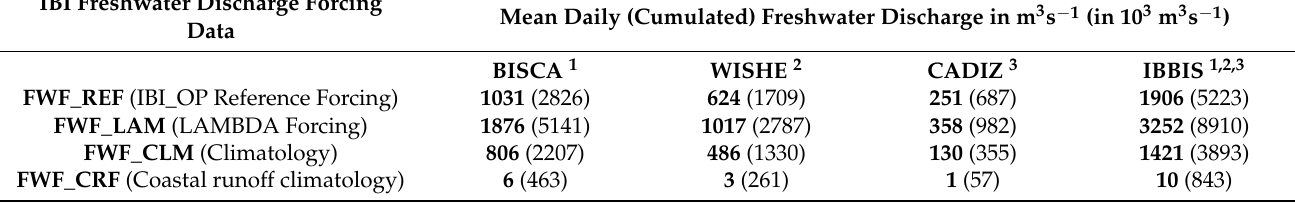
Table 3. Mean daily river discharge (m 3 s − 1 ) and cumulated discharge (10 3 m 3 s − 1 ) over 2018 for each forcing set, in the full study domain (IBBIS) and the three subregions (BISCA, WISHE,